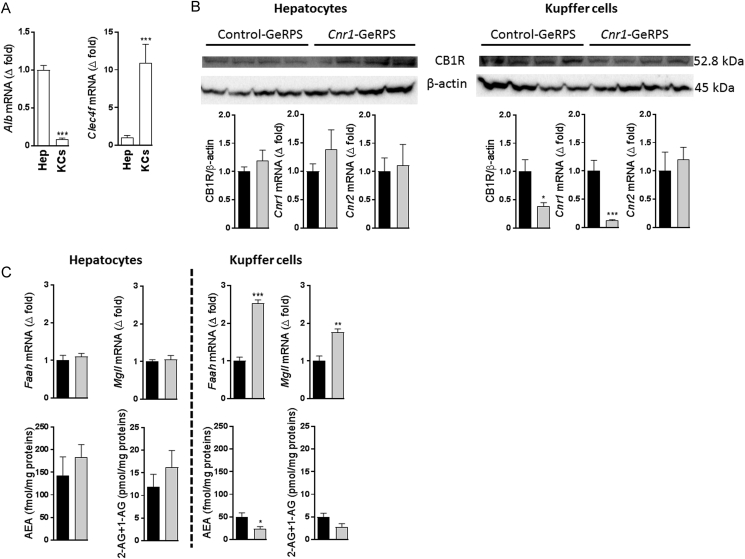
In vivo Cnr1 knock-down in Kupffer cells reduces the endocannabinoid tone in these cells. A Relative expression of Alb and Clec4f in hepatocyte and Kupffer cell fractions, with levels in hepatocytes defined as 1.0. B CB1R protein quantification by western blot and Cnr1/Cnr2 gene expression in hepatocytes or Kupffer cells isolated from DIO mice treated with control (black columns) or Cnr1-GeRPs (grey columns). C Gene expression for Faah and Mgll and endocannabinoid (AEA and 2-AG) quantification in hepatocyte and Kupffer cell fractions from DIO mice treated either with control (black columns) or Cnr1-GeRPs (grey columns). Columns and bars represent means ± SEM. Significant differences from values in DIO mice treated with control-GeRPs, *P < 0.05, **P < 0.01, ***P < 0.001.